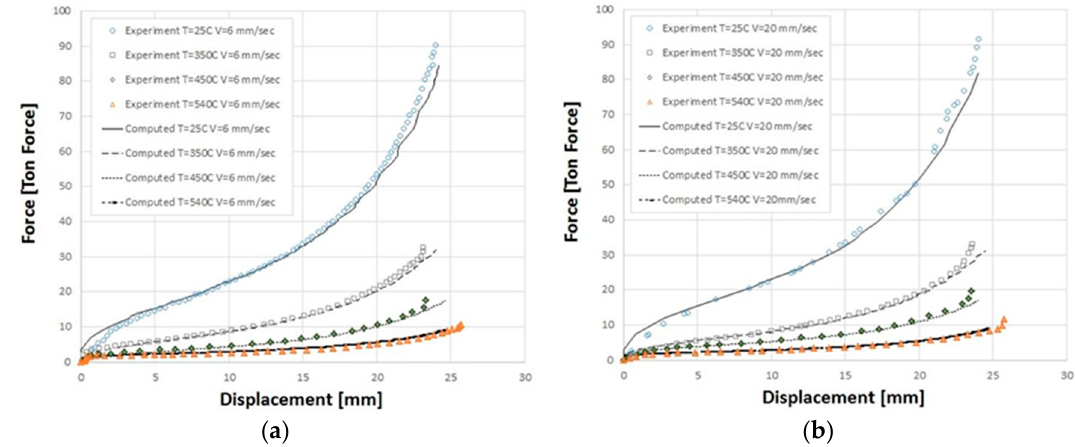
Figure 10. Comparison between experimental and computed force-displacement curves for the Al1050 upsetting process, at different temperatures for ⟨ ε ̇ zz ⟩ = 0.11 ( a ) and ⟨ ε ̇ zz ⟩ = 0.38 ( b ).